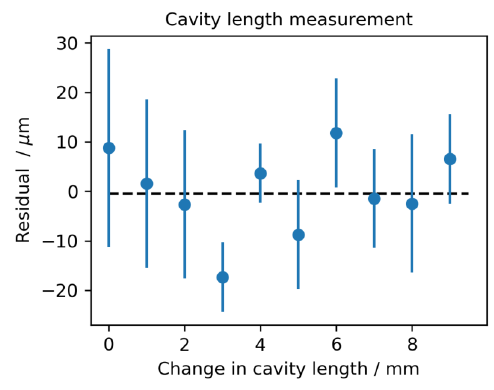
Figure 3. Verifying the absolute distance measurement: A cav- ity consisting of the Fizeau reference flat and a flat specimen was set up. The cavity length was changed, and the change was measured with a commercial laser interferometer with nanome- tre precision. The absolute cavity lengths were also measured with the Fizeau interferometer. The figure shows the residuals of the change in cavity length calculated from the absolute distance measurement in comparison to the laser interferometer measure- ment. Each data point corresponds to the average of 20 measure- ments with its standard deviation shown as an error bar.